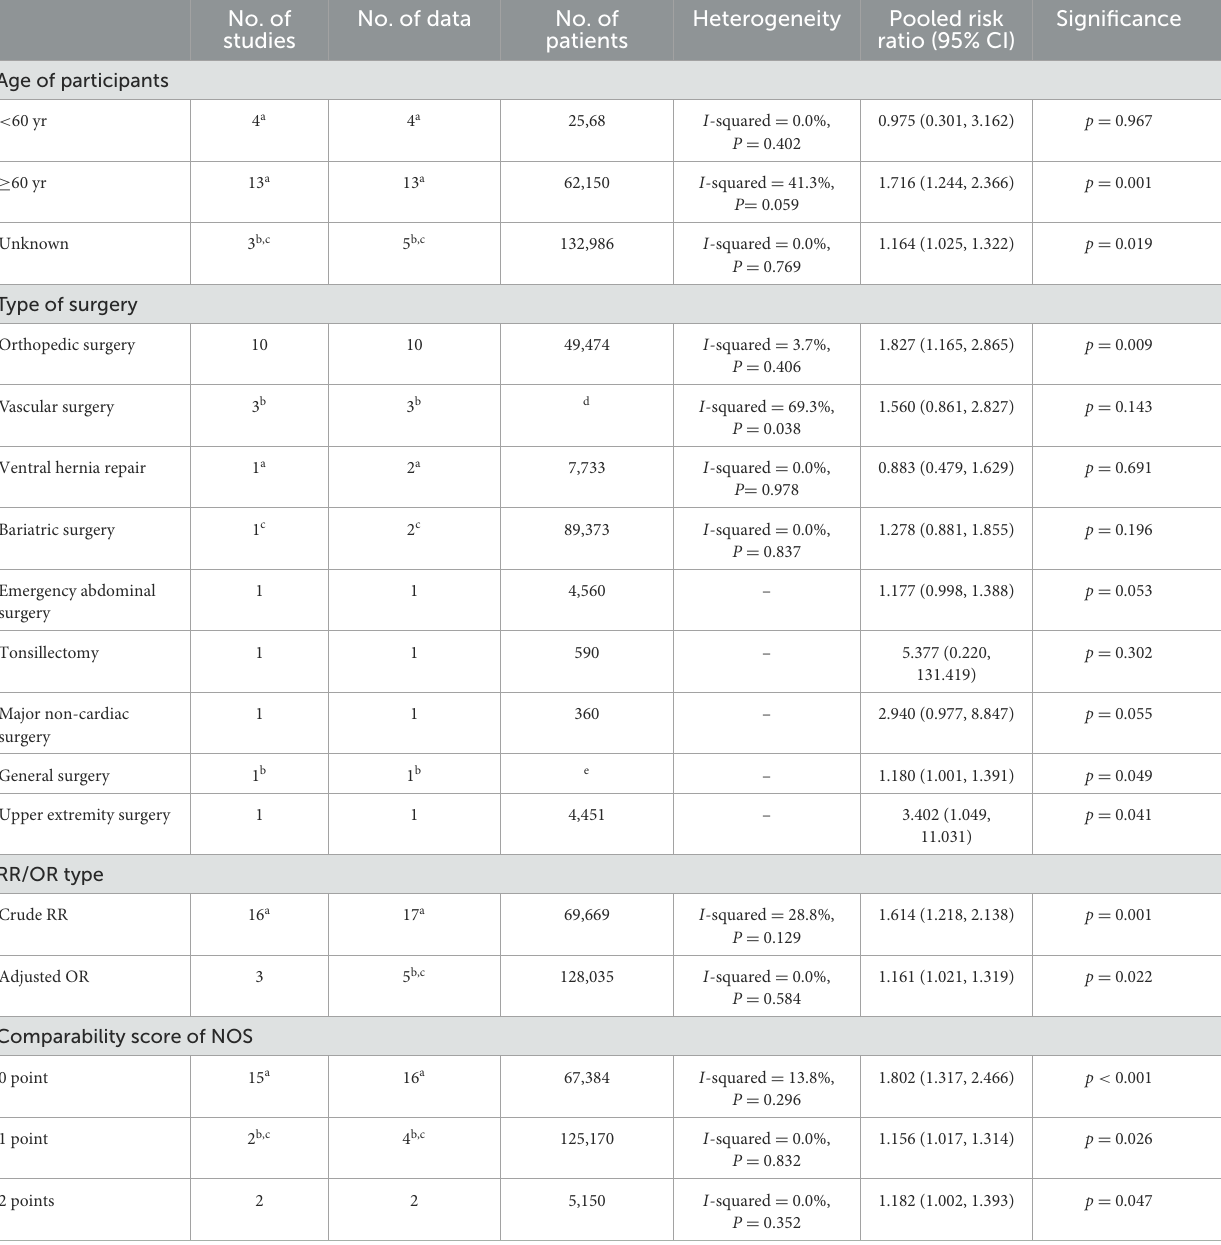
TABLE 3 Results of subgroup and sensitivity analyses for risk of 30-day mortality.